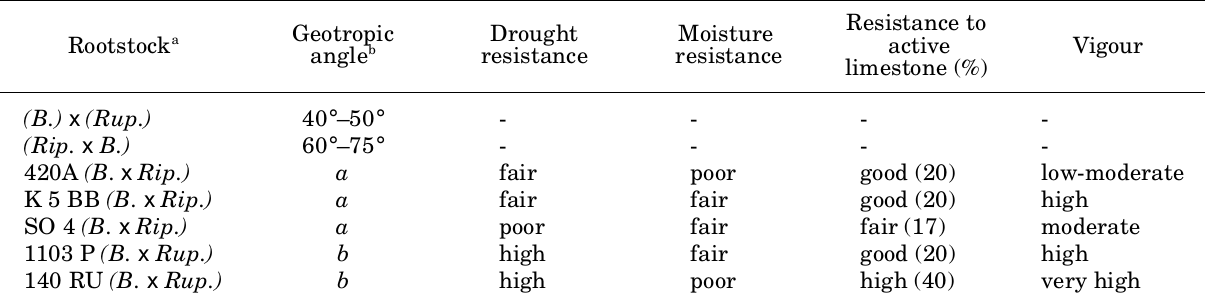
Table 1. Main agricultural characteristics of rootstocks used in the vineyards CBSI-1, CBSI-2 and CBSI-2 (Bavares- co, 1998; Fregoni, 1998) Resistance to Geotropic Drought Moisture Rootstock a active Vigour angle b resistance resistance limestone (%) (B.) x (Rup.) 40 ° –50 ° - - - - (Rip. x B.) 60 ° –75 ° - - - - 420A (B. x Rip.) a fair good (20) low-moderate K 5 BB (B. x Rip.) a fair fair good (20) high SO 4 (B. x Rip.) a poor fair 1103 P (B. x Rup.) b high fair good (20) high 140 RU (B. x Rup.) b